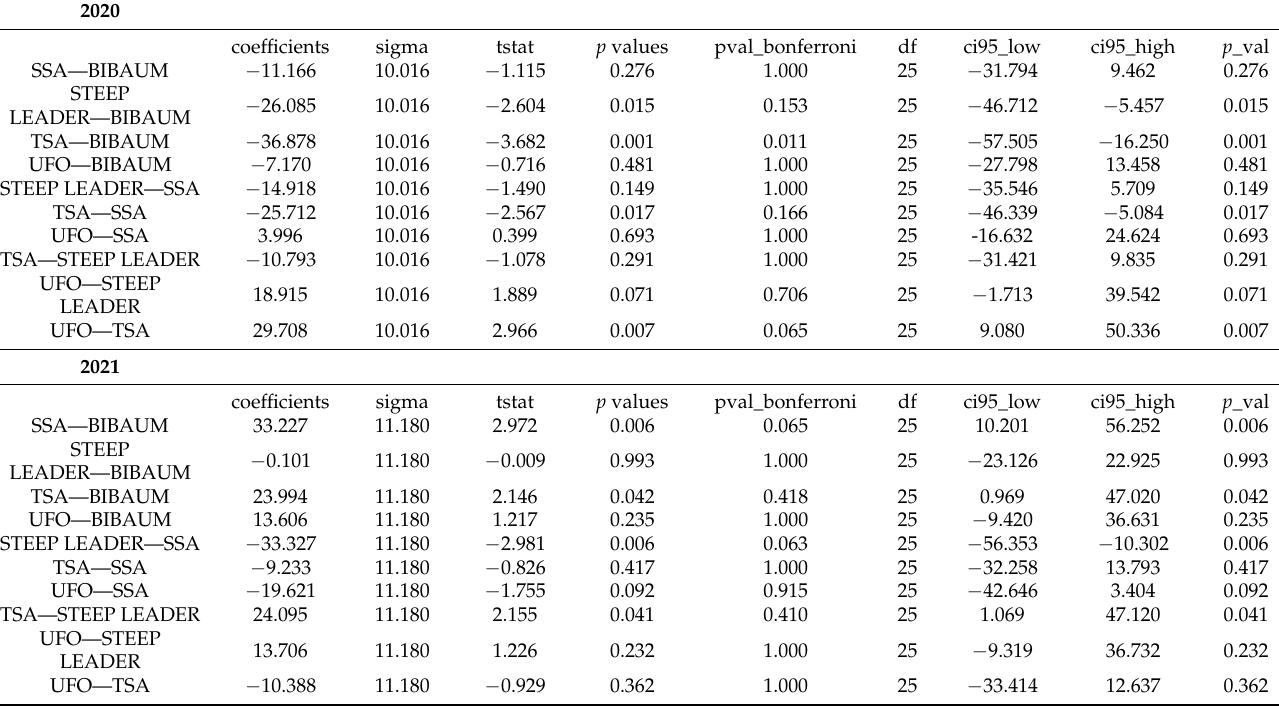
Table A2. Compression